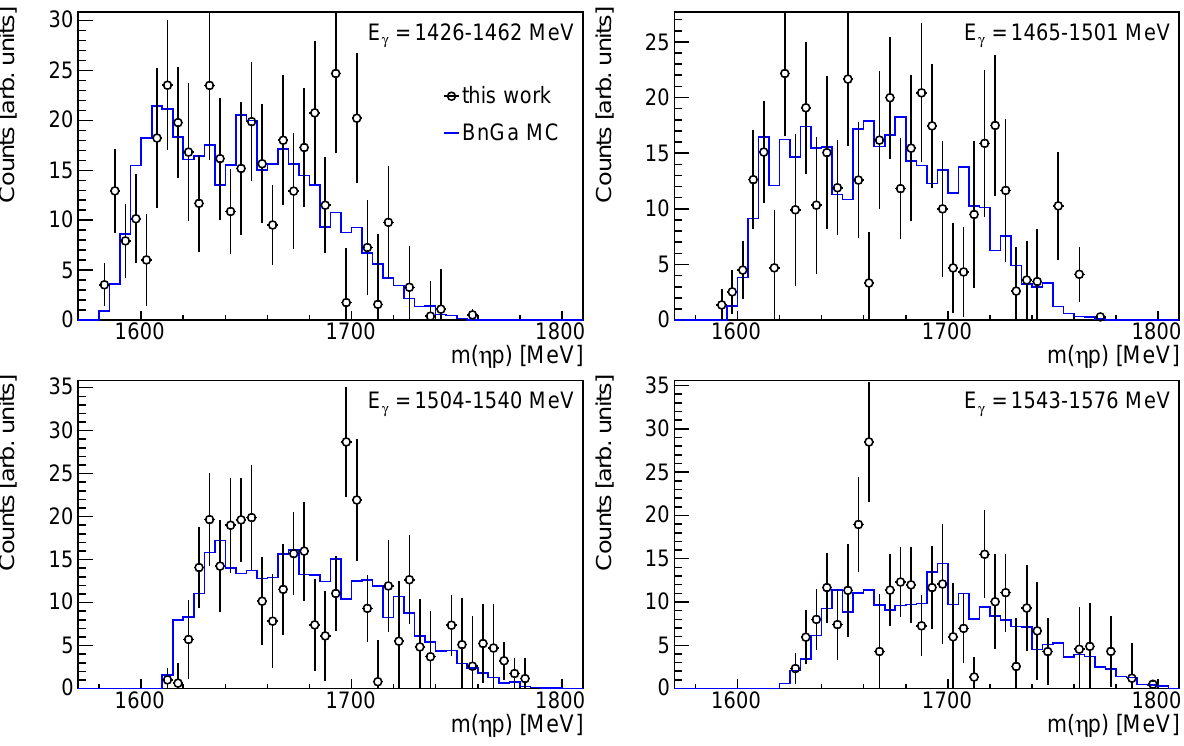
Figure 8. Invariant mass m ( η p ) of γ p → ηπ 0 p for four bins of photon-beam energy with m ( π 0 p ) < 1180 MeV for events in the Van Hove plot-sector S5 (no acceptance correction). The data (black circles) are compared to a phase-space MC simulation (blue curves, normalized by integral ratio) using event weights from the BnGa partial-wave analysis of